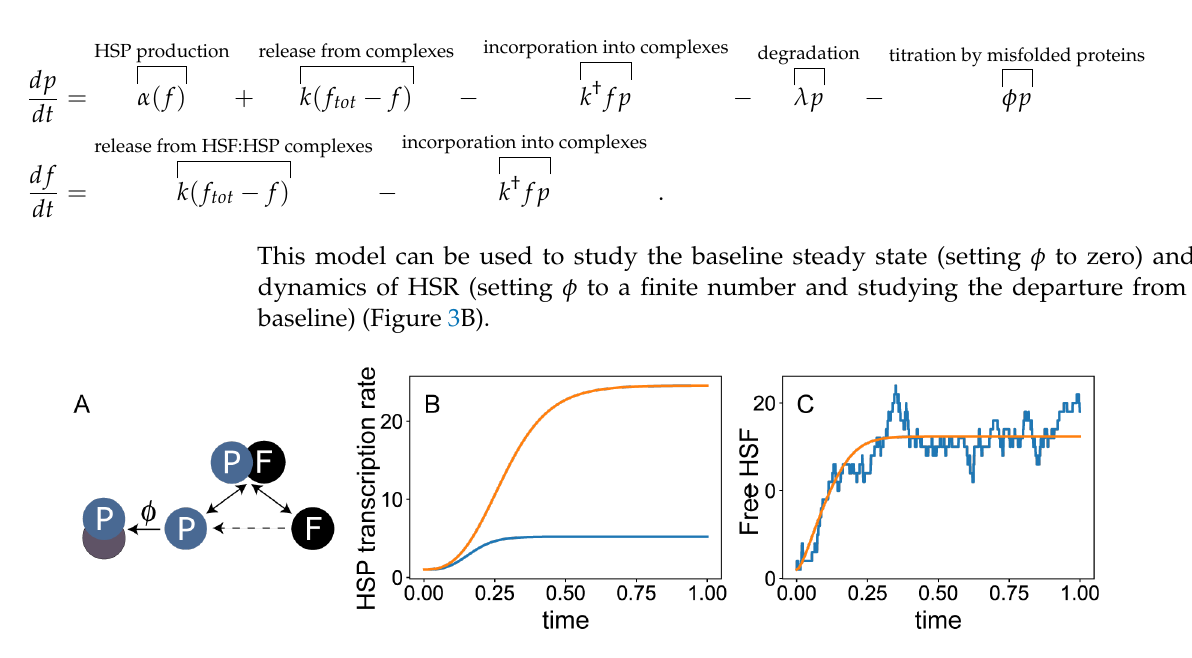
Figure 3. The core of the mathematical models of the HSR. ( A ) An overly simplified model. This model explicitly considers only two species, HSF and HSP. While HSPs are created and destroyed, it is assumed that the total concentration of HSF is conserved. ( B ) Simulation of the model with two levels of heat-shock, accounted for through the flux φ of titration of HSP by misfolded proteins. ( C ) Comparison between the increase in HSF concentration after heat shock as predicted by an ODE-based model (orange), and by a stochastic simulation of the model